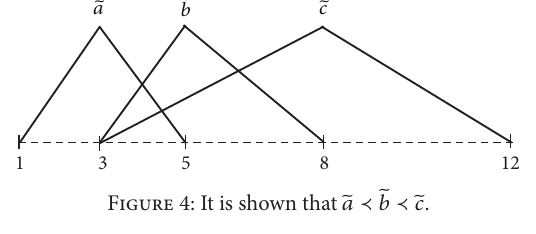
Figure 4: It is shown that ̃𝑎 ≺